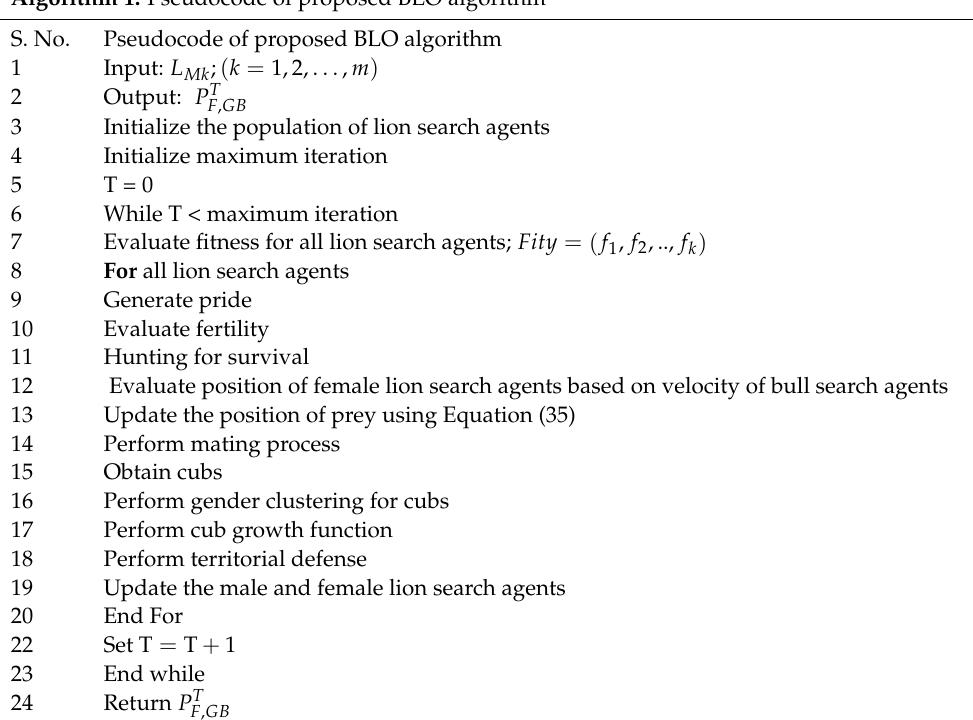
Algorithm 1: Pseudocode of proposed BLO